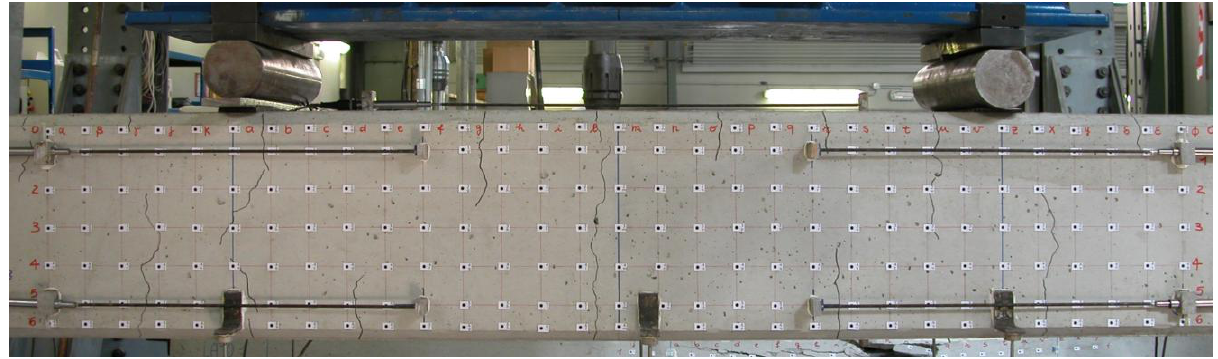
Figure 4. A beam can be considered a flat